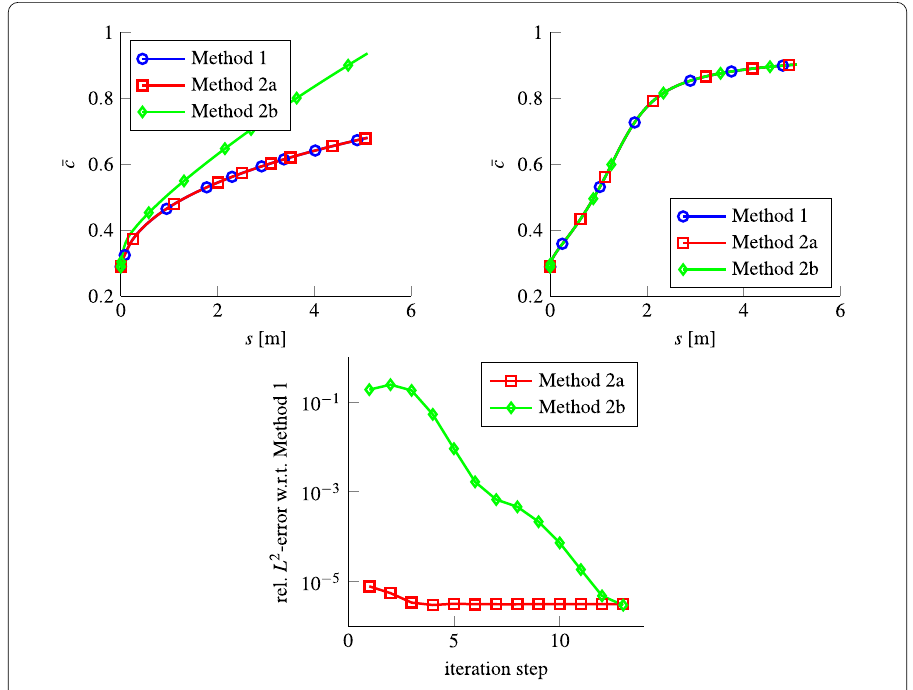
Figure 4 Comparison of averaged polymer mass fraction ¯ c obtained with Method 1, Method 2a and Method 2b. Top-left: After second iteration step. Top-right: After 13th iteration step (converged). Bottom: Relative L 2 -error with respect to the solution obtained by Method 1 as